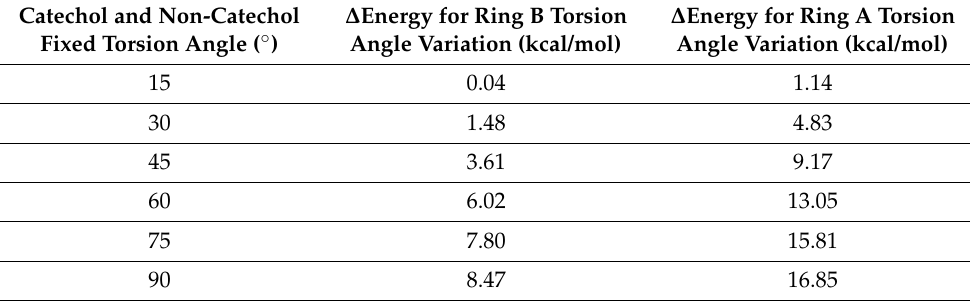
Figure 10. The Butein semiquinone radical of Figure 9 reacts with an additional superoxide radical, π – π approach, to produce this minimum energy structure after geometry optimization. The interacted ring B is flat, due to the O(carbonyl)–H(hydroxyl) hydrogen bond, and so the alternative attack of superoxide from above the ring should produce an equivalent minimum. Table 3. Conformational variation of Butein. Individual single point energy calculations were performed for the torsion angle associated with the catechol ring (central column) or to the non- catechol ring. They were subtracted by the energy of DFT minimum obtaining ∆ Energy. Torsion angles were fixed every 15 ◦